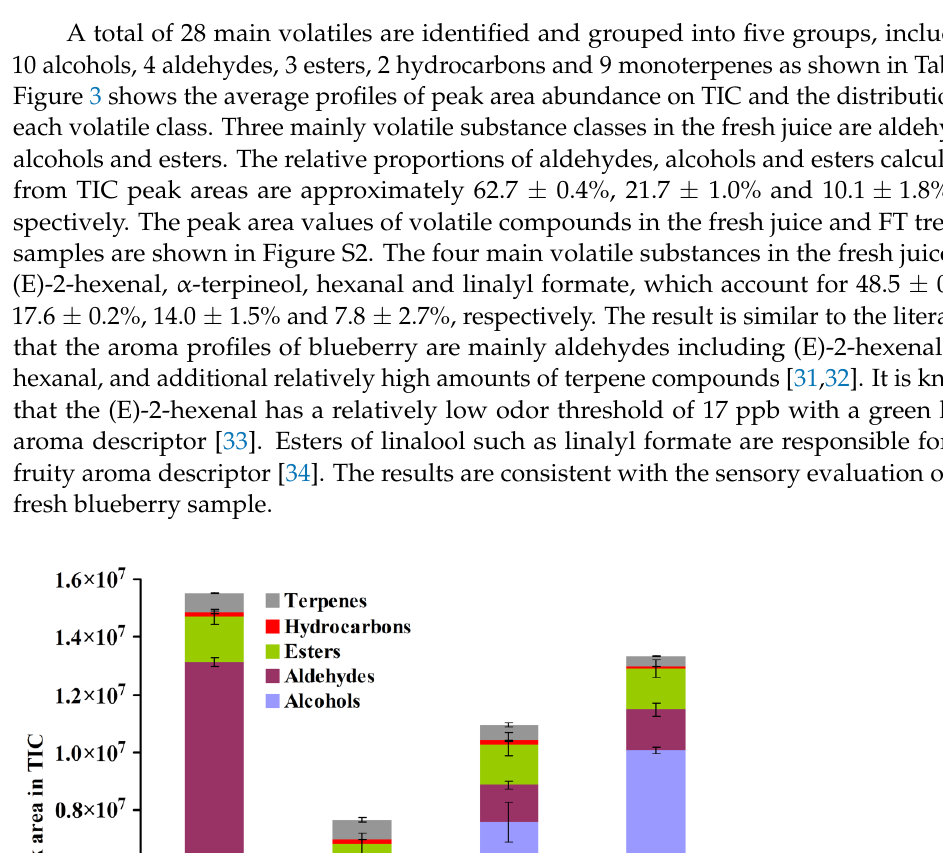
Table 2. Volatile organic compounds found in different freeze-thaw (FT) treated samples and its relative proportion (%) based on total ion chromatogram (TIC) peak areas in headspace gas chromatography-mass spectrometry. FT-1, FT-2 and FT-3 represent the sample with FT treatment once, twice and third times.